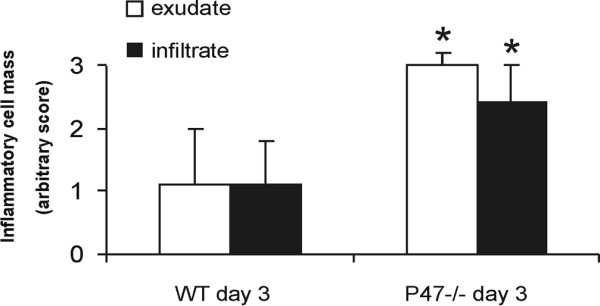
Knee joints, 3 days after induction of ICA in p47phox-/- mice and their WT controls. The numbers of cells present in the synovium (infiltrate) and in the joint cavity (exudate) were determined on an arbitrary scale from 0 to 3: 0, no cells; 1, few; 2, moderate; 3, maximal. The number of cells was determined by two blinded observers. Data are means ± SD for eight animals. Significance was tested with the Wilcoxon rank test (*P < 0.05).